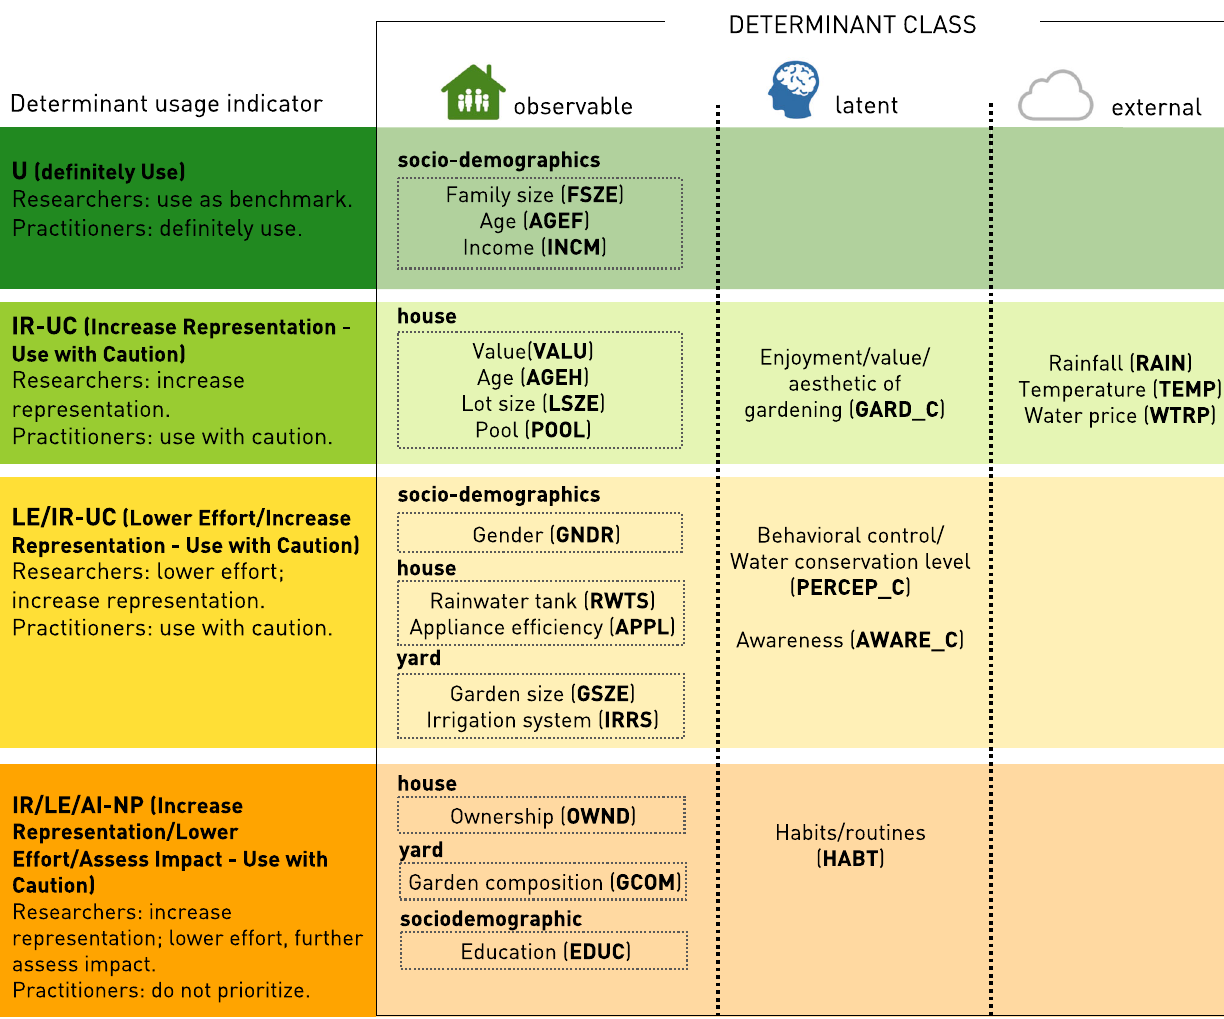
Fig. 8 Household water consumption determinant classi fi cation and associated recommendations for practitioners and researchers based on individual determinants. Each household water consumption determinant identi fi ed in the framework analysis papers is associated with a level of recommendation. Determinants are classi fi ed according to the three de fi ned classes (columns), i.e., observable, latent, and external. Four levels of recommendation (rows) are formulated for practitioners and researchers. They are sorted in decreasing order of representation and proven impact in research, as well as con fi dence for use in practical applications. Con fi dence for use in practical applications decreases going from green ("U" level of recommendation) to orange ("IR/LE/AI-NP" level of